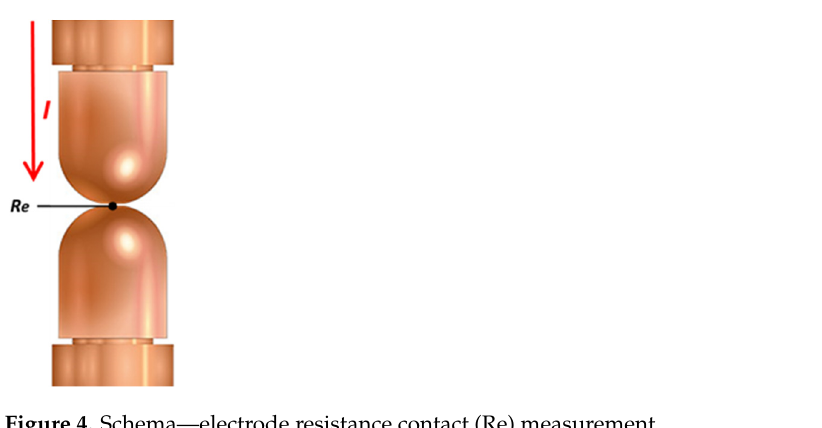
Figure 3. Evolution of the state of the electrodes. ( a ) Type F electrode before milling. ( b ) Type F electrode after good milling. ( c ) F-type electrode after poor milling.